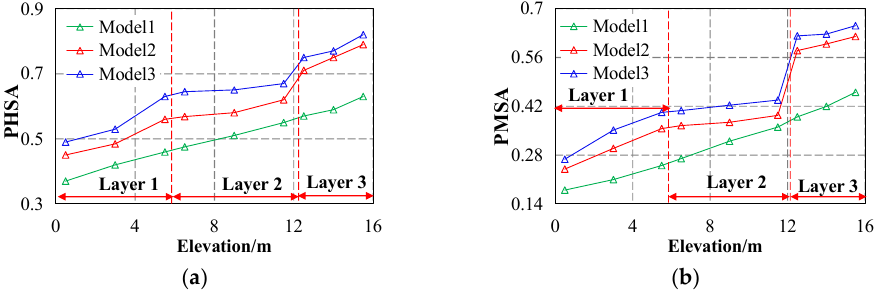
Figure 17. Change of PMSA and PHSA with increasing elevation: ( a ) PMSA and ( b ) PHSA.